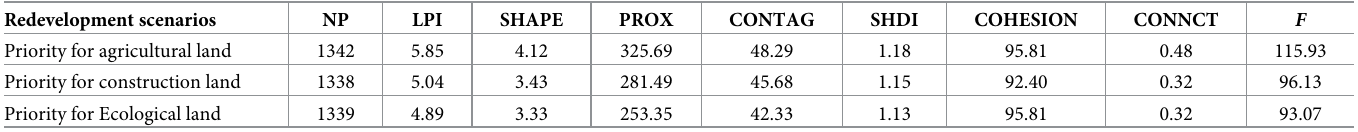
Table 5. Evaluation of spatially concentrated